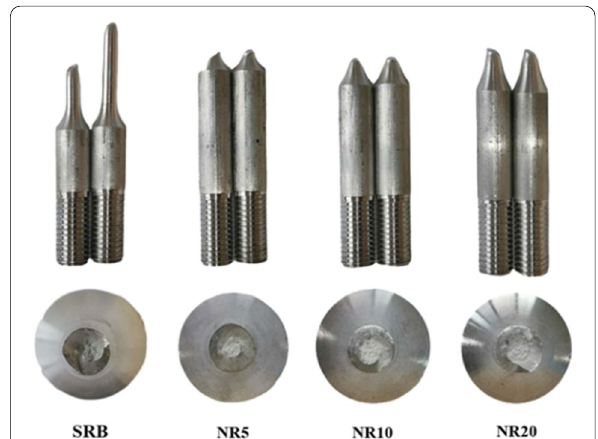
Figure 3 Fracture phenomena in the tension test